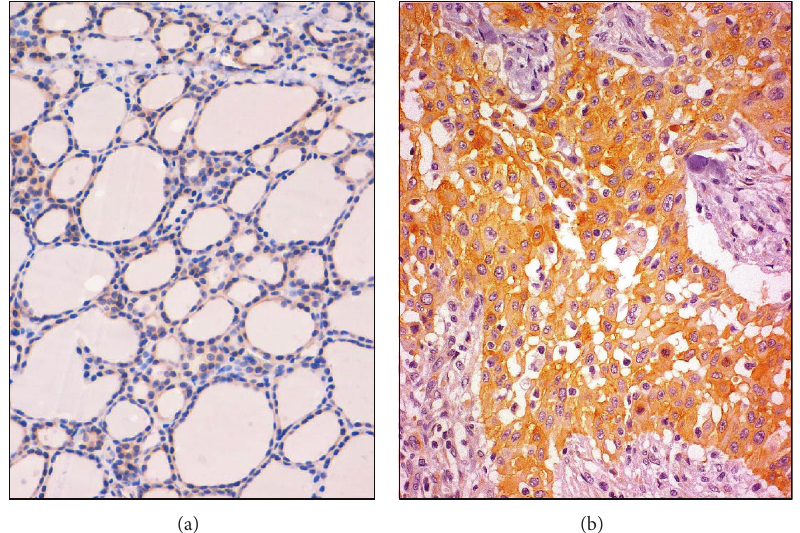
Figure 1: (a) Cells of a nodular goiter showing a weak and cytoplasmic staining for TfR1/CD71. (b) In ATC TfR1/CD71 is diffusely expressed both in the cytoplasm and in the cell surface of neoplastic cells.